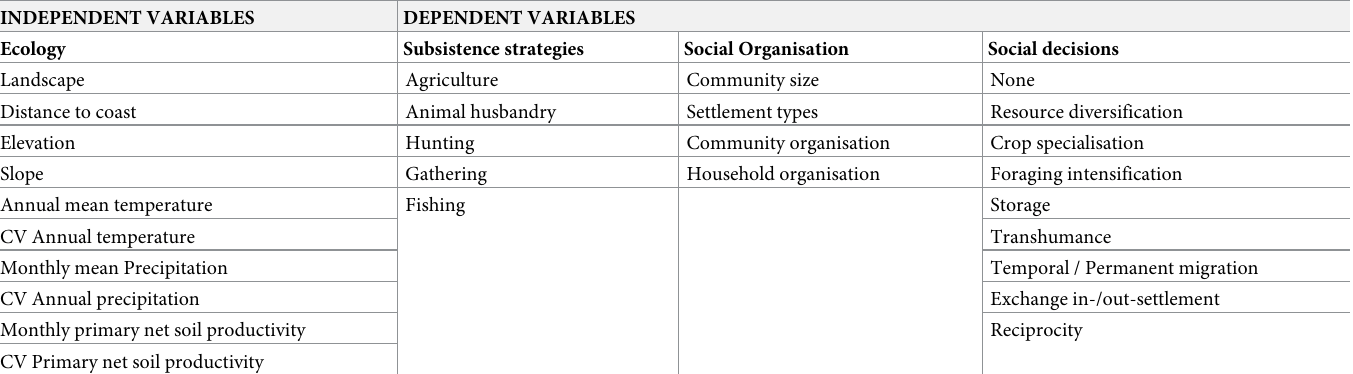
Table 1. Summary of relevant variables to consider for modelling socio-ecological